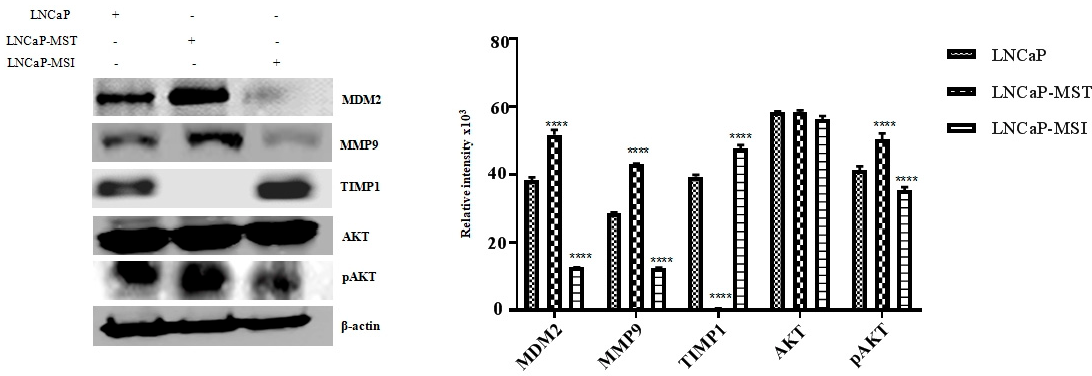
Figure 4. Levels of MDM2, MMP9, TIMP1, AKT and pAKT protein expression in LNCaP and LNCaP-MST and LNCaP-MSI cells. In these western blotting experiments, the expression level of β -actin was used as a loading control (**** p < 0.0001).